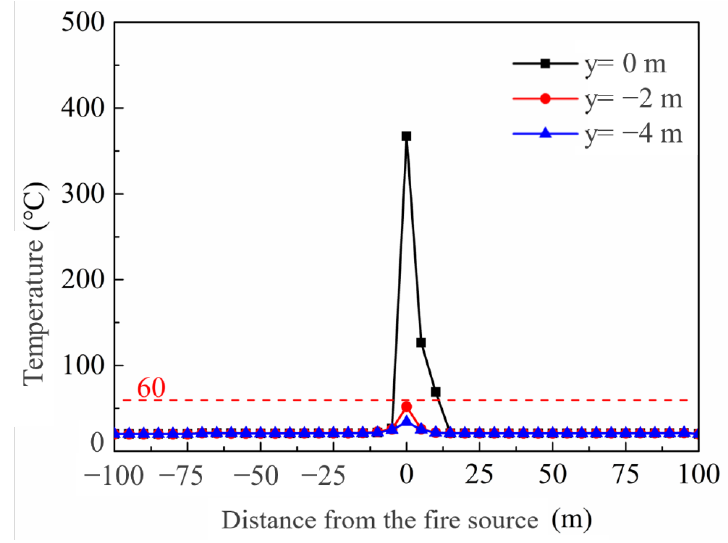
Figure 15. Temperature distribution at 1.8 m height.